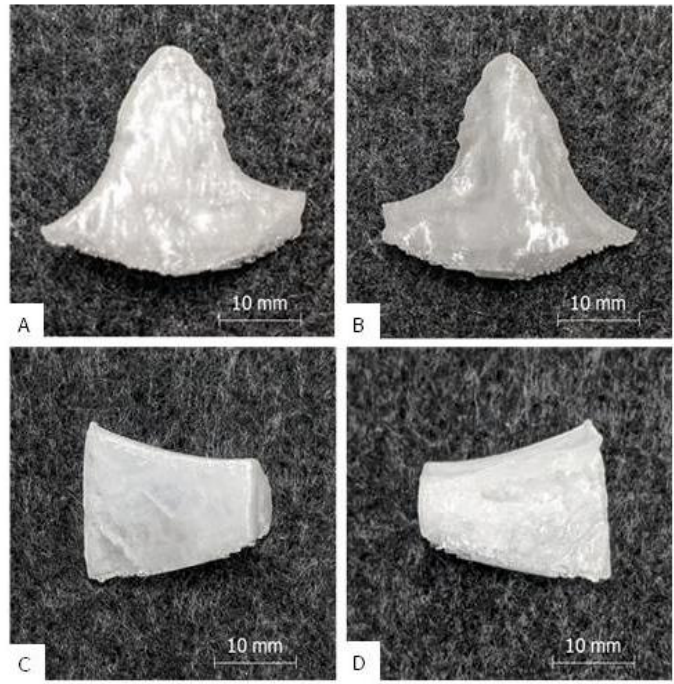
Figure 3. Results of the single print: Picture ( A ) shows the outside of implant B, picture ( B ) the inside. Picture ( C ) [7] shows the outside of implant A, picture ( D ) [7] the inside (with porous inner bone structure).